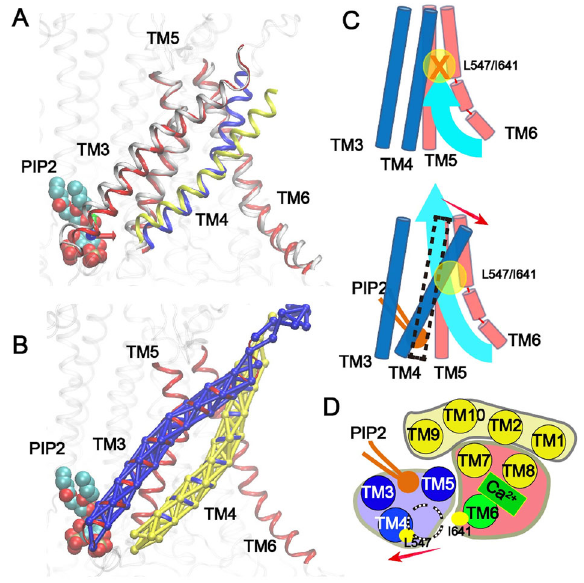
Fig. 5 Rearrangement of TMs during PIP 2 -induced TMEM16A pore reactivation. A TM conformations in the closed (TMs 3, 5, 6: red; TM4: blue) and activated (TMs 3, 5, 6: white; TM4: yellow) states. B Dynamic network analysis reveals that TMs 3 and 4 are clustered into two large independent communities (blue and yellow networks, respectively). In A and B , only the headgroup of PIP 2 is shown for clarity. C , D Schematic illustration of the TM movement during TMEM16A pore reactivation ( C : side view; D : top view). The binding of PIP 2 triggers largely rigid-body movement of TMs 3 – 5, particularly TM4 (highlighted by the red arrows), leading to the dilation of the pore near the neck region (yellow circles in panel C and dashed circle in panel D